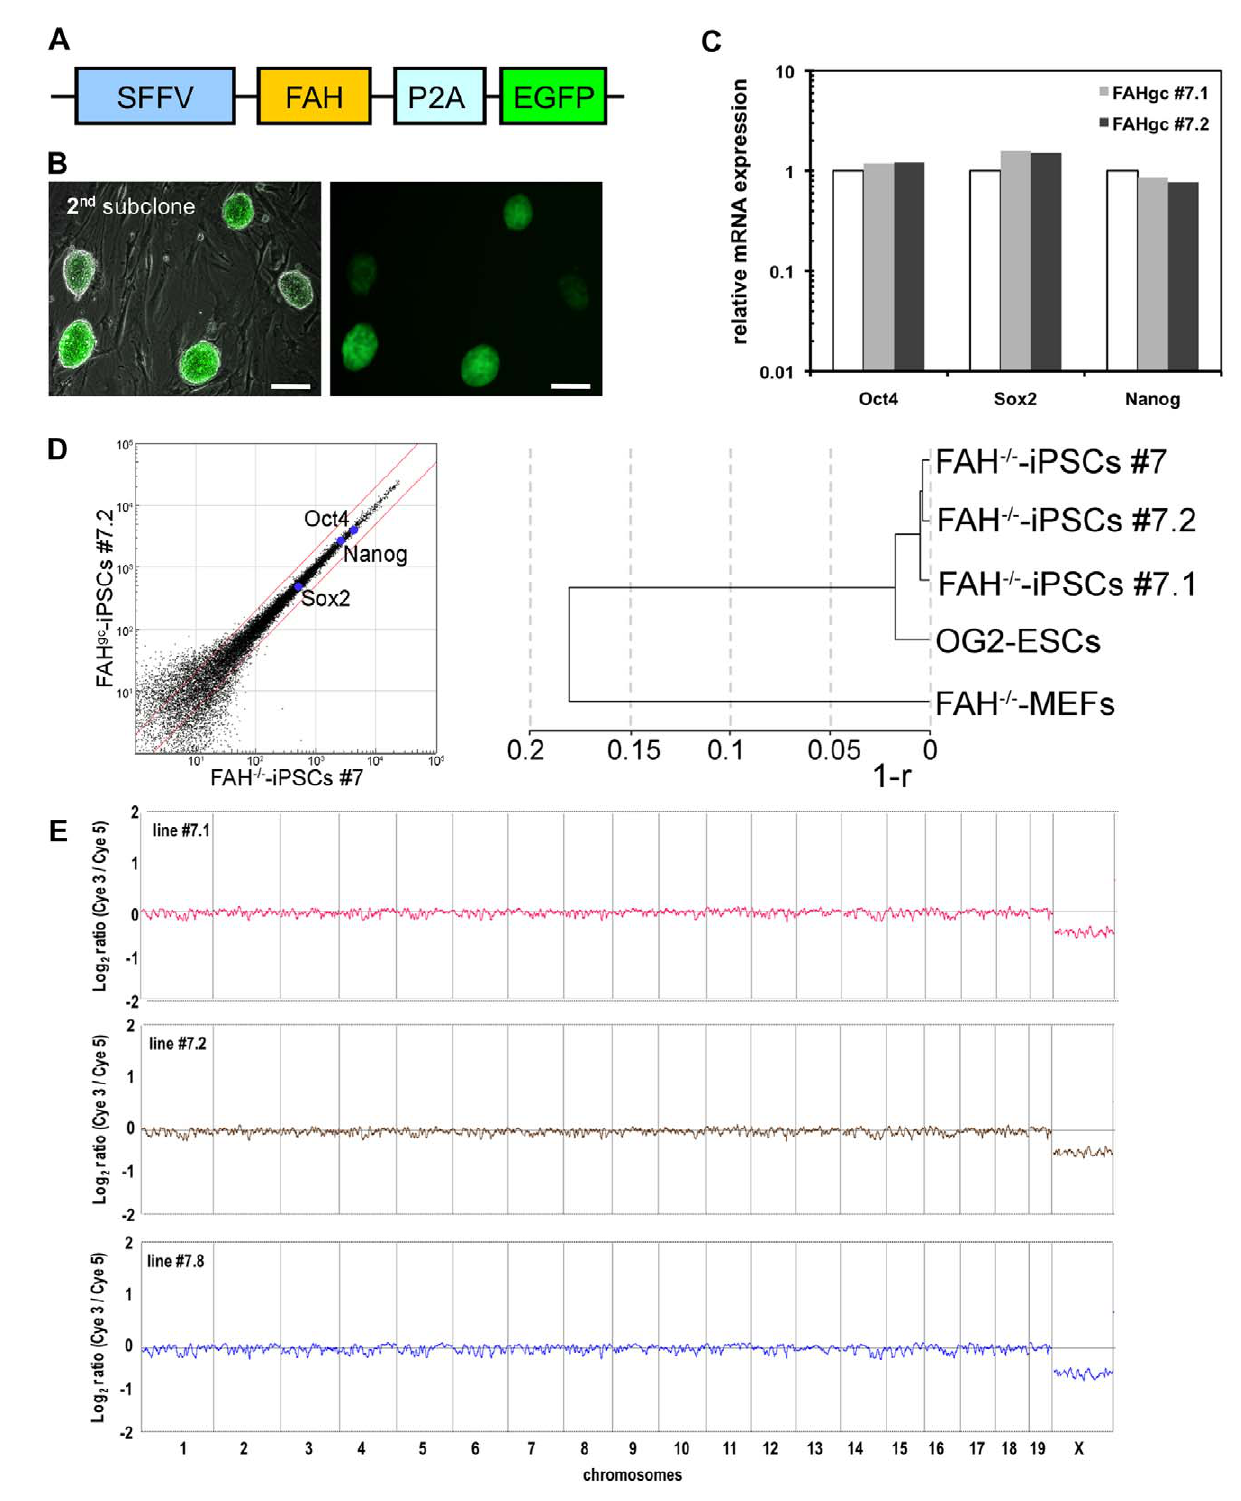
Figure4.Geneticcorrectionof FAH 2 / 2 -iPScells. (A)Designofthelentiviralconstructforgenecorrectionof FAH 2 / 2 cells:Anintact FAH cDNAwasexpressed in conjunction with EGFP, linked by a 2A-peptidase motif (P2A) for coexpression, under the transcriptional control of the spleen focus-forming virus ( SFFV ) promoter. (B) After transduction of FAH 2 / 2 -iPS cells in single-cell suspension, colonies showing homogenous EGFP expression were subcloned. A second subcloningstepwasappliedtoensureclonalityofthegene-corrected FAH gc -iPScelllines,asdepictedforline # 7.2.Scalebars,100 m m.(C)QuantitativeRT-PCRfor the pluripotency factors Oct4 , Sox2 , and Nanog in FAH gc -iPS cells ( # 7.1 and # 7.2) compared with OG2 ES cells (normalized to 1). (D) Scatter plot of global gene expression data comparing FAH gc -iPS cell line # 7.2 with FAH 2 / 2 -iPS cell line # 7, and dendrogram of the indicated samples based on global expression profile similarity (r: linear correlation coefficient). (E) Array CGH analyses of the male gene-corrected FAH gc –iPS cell lines # 7.1, # 7.2, and # 7.8 showed no detectable chromosomal aberrations, compared with the sex-mixed starting fibroblast (MEF) population. doi:10.1371/journal.pbio.1001099.g004 PLoS Biology |